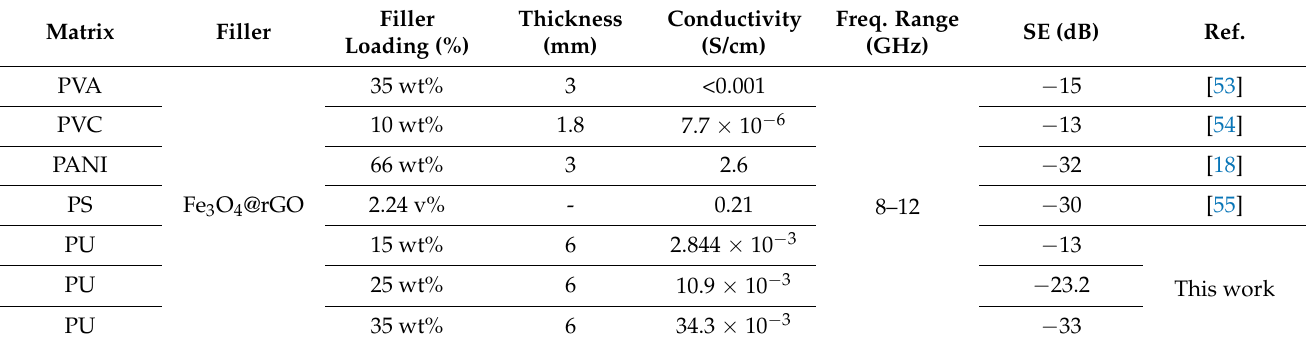
Table 6. A comparison between this work and the literature.